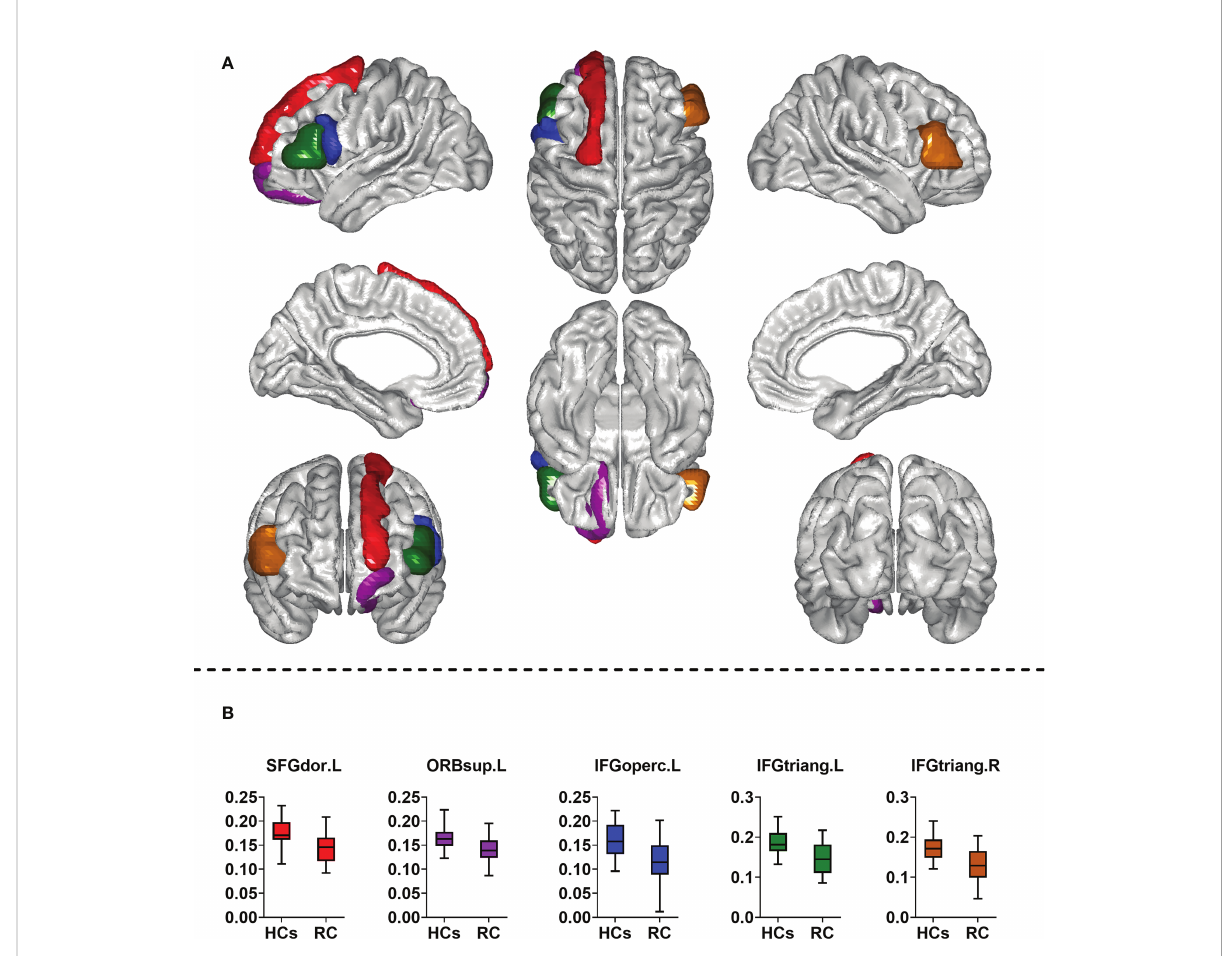
FIGURE 3 Comparison of nodal measures between groups. RC, rectal cancer; HCs, healthy controls. SFGdor. L, left superior frontal gyrus (dorsolateral); ORBsup.L, left superior frontal gyrus (orbital part); IFGoperc.L, left inferior frontal gyrus (opercular part); IFGtriang.L, left inferior frontal gyrus (triangular part); IFGtriang. R, right inferior frontal gyrus (triangular part). Two sample t -tests were employed for statistical analysis. In addition, false discovery rate (FDR) method was used to correct for multiple comparisons. Corrected P < 0.05 indicated statistically signi fi cant differences. (A) Brain regions with altered nodal global ef fi ciency; (B) Comparison of nodal global ef fi ciency between